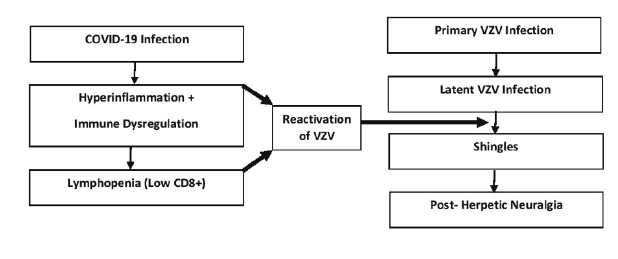
Figure 1 - Pathogenesis of VZV Reactivation in